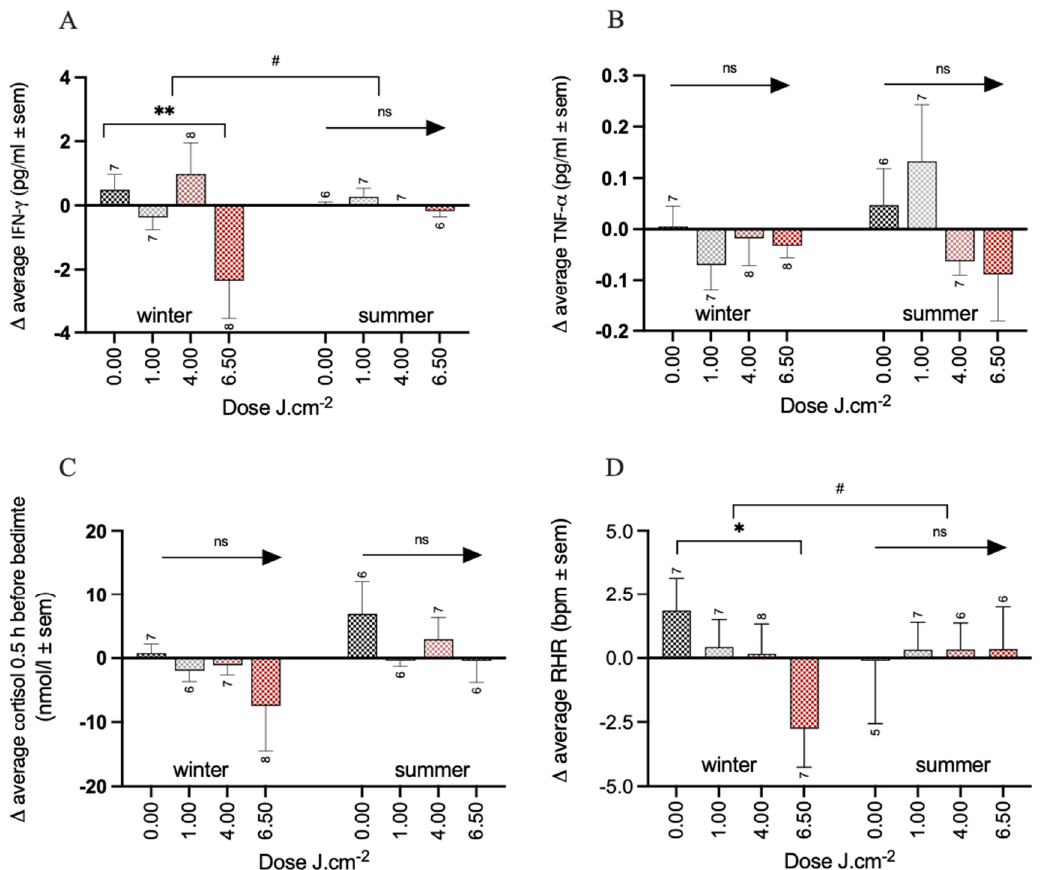
Figure 5. Overview of all individual elements of the health composite score for the summer and winter separately. ( A ) IFN-γ, ( B ) TNF-α, ( C ) cortisol 0.5 h before bedtime, and ( D ) RHR of the night after 2 and 4 weeks of PBM. Significance codes: ** p < 0.01, * p < 0.05, # p < 0.1 ns: not significant. Sample sizes per condition are shown.